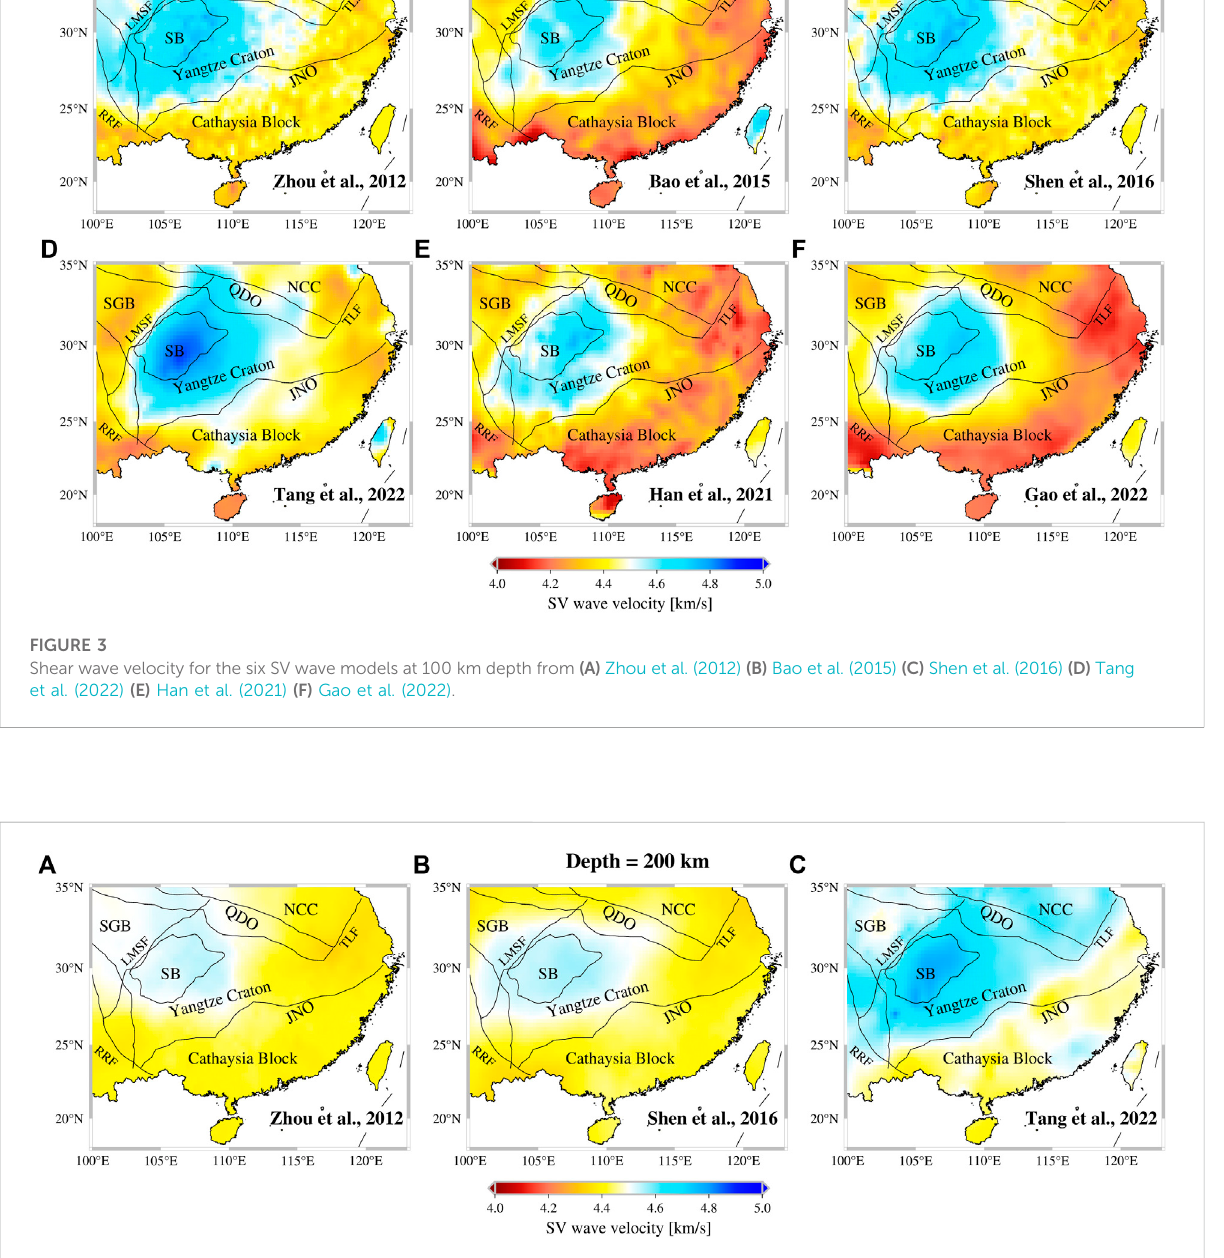
FIGURE 4 Shear wave velocity for the three SV wave models at 200 km depth from (A) Zhou et al. (2012) (B) Shen et al. (2016), and (C) Tang et al.